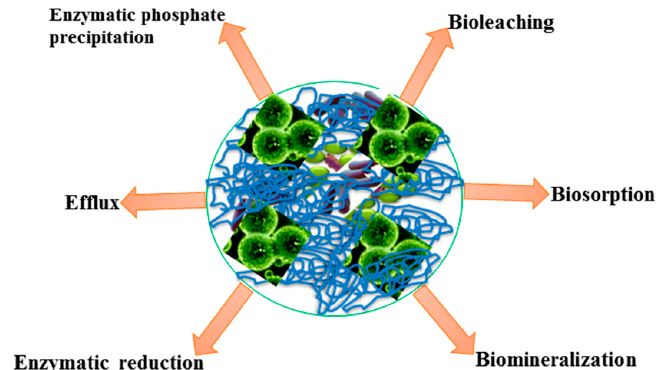
Figure 2. A typical representation of various modes of bio-reclamation process.